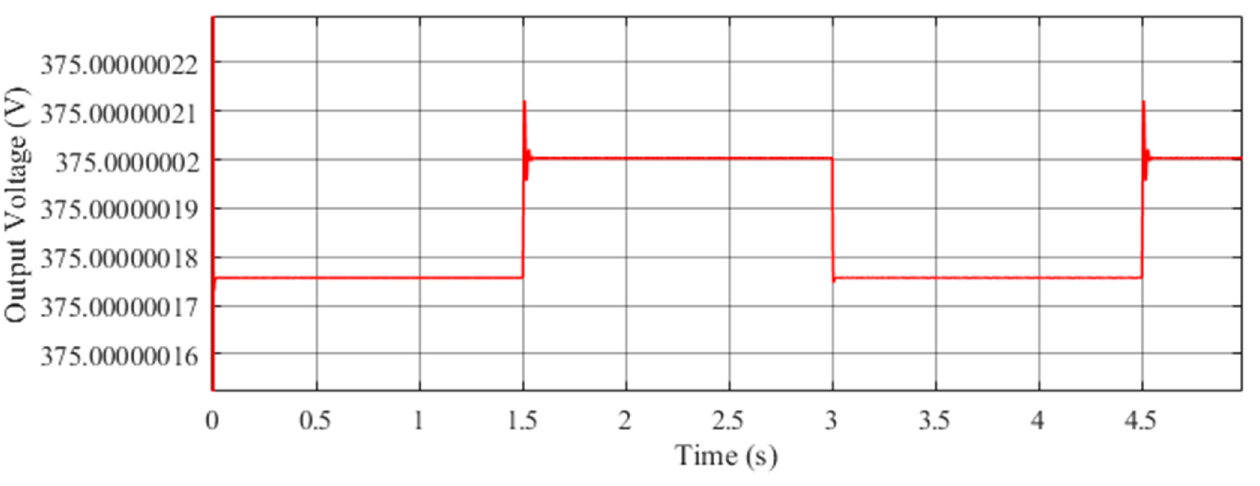
Figure 19. Output voltage in d - q frame during solar radiations variations.